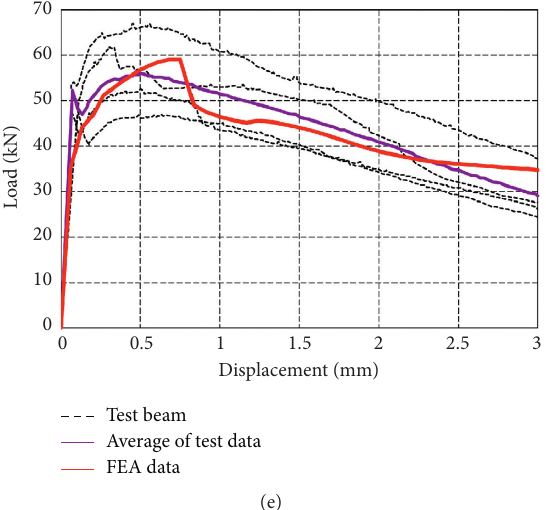
Figure 9: Test results compared with meso-scale numerical simulation results. (a) M_1. (b) M_2. (c) M_3. (d) M_4. (e)